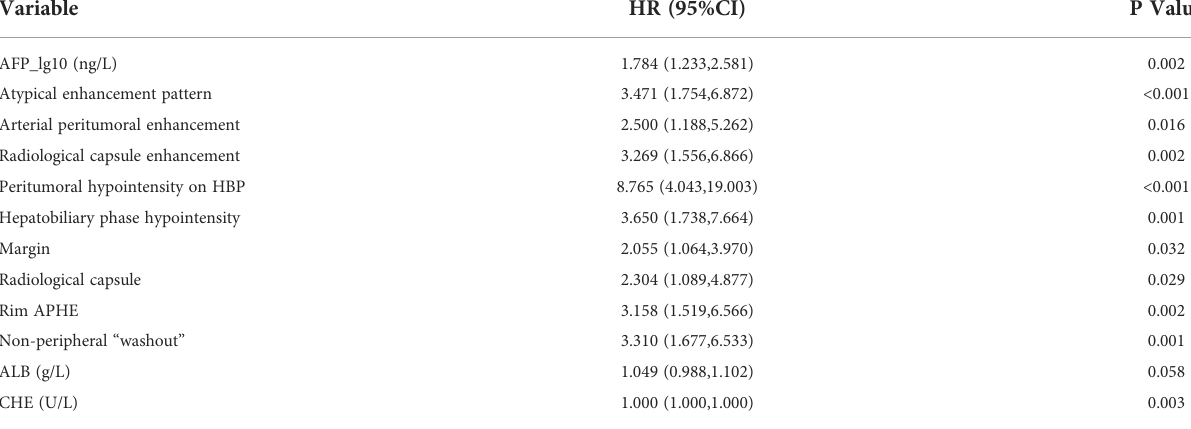
TABLE 2 Univariate analysis factors predictive of MVI.